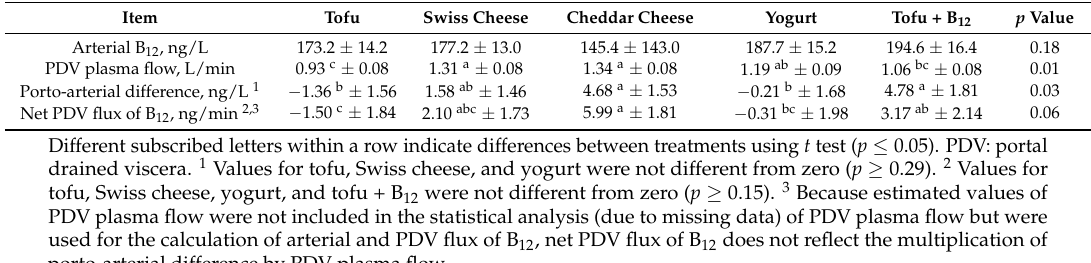
Table 2. Average B 12 arterial concentration, PDV plasma flow, porto-arterial difference, and net PDV flux of vitamin B 12 during 23 post-prandial hours according to dietary